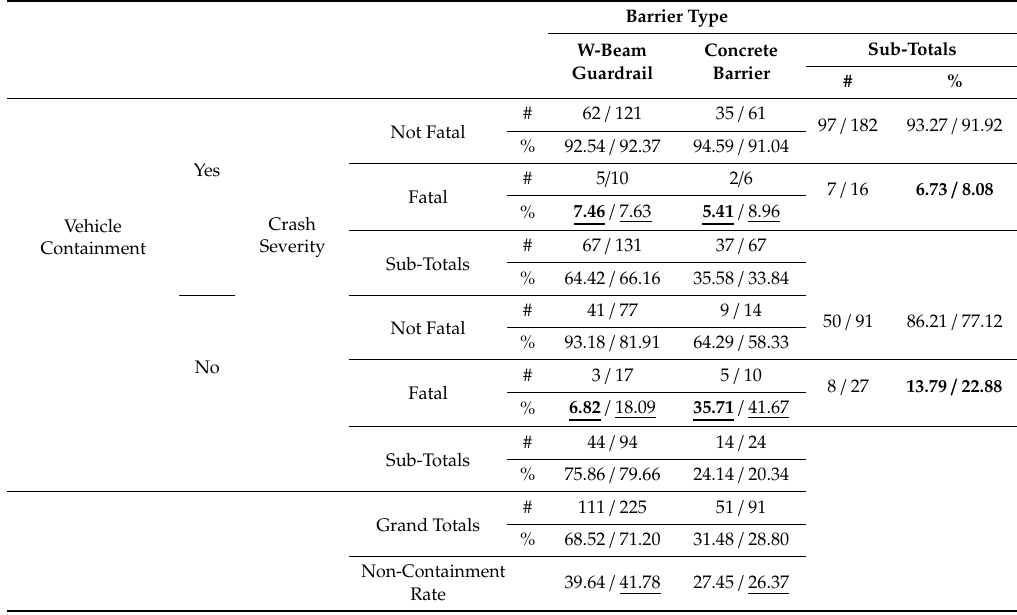
Table 5. Crash Severity Distribution by Barrier Type and Vehicle Containment